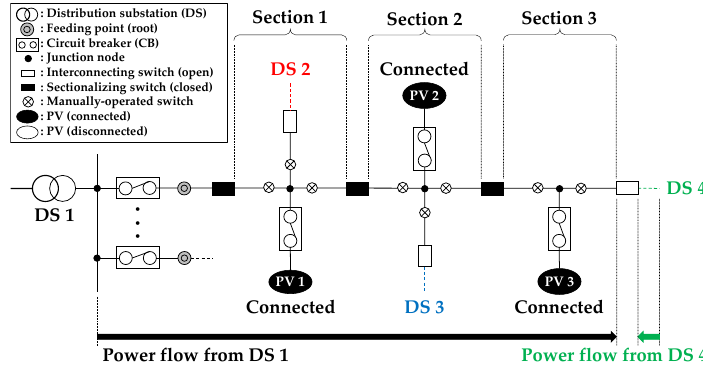
Figure 1. Distribution network model (normal condition).